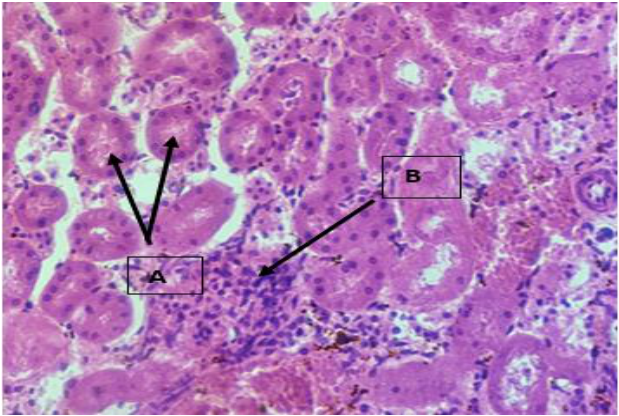
Fig. 8. Photomicrograph of rat kidney showing eosinophilic material in the lumen of convoluted Tubules (A) and diffuse inflammatory infiltrates (B)[ARS 100 group